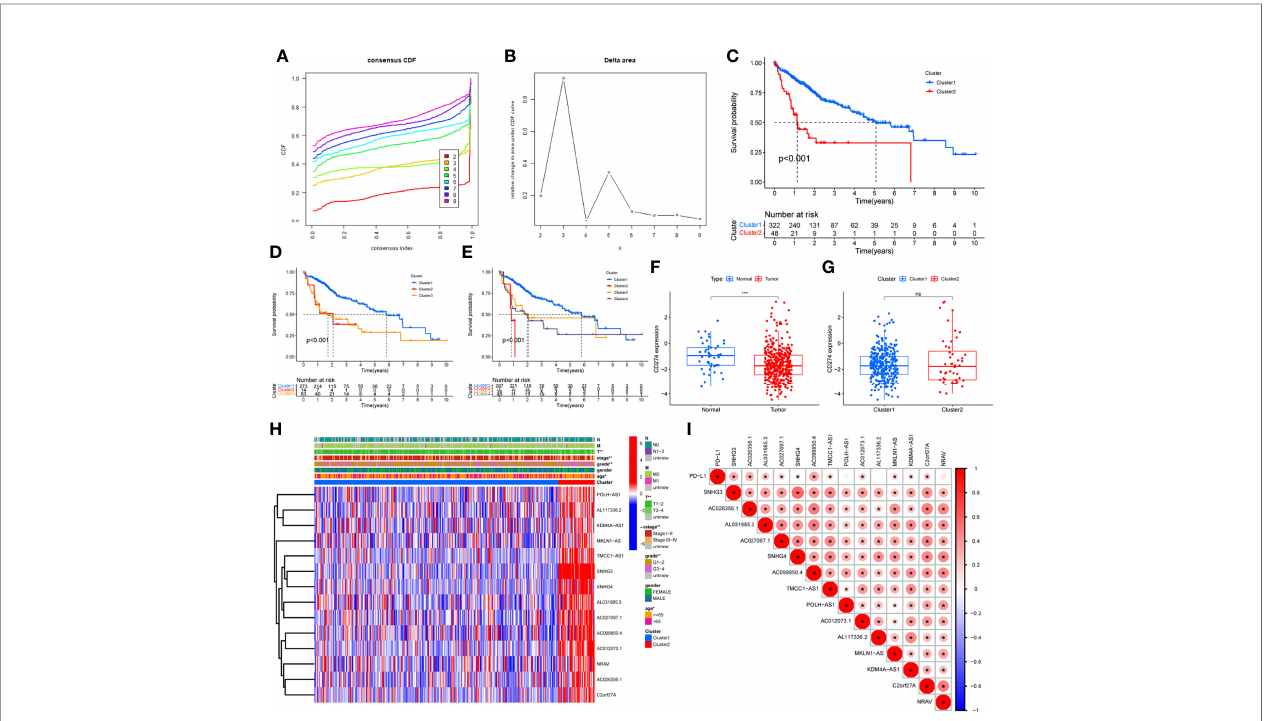
FIGURE 2 | Differential expression, correlation analysis, and survival analysis of lncRNAs. (A, B) Consensus cumulative distribution function and delta area plots, (C – E) Survival analysis by cluster 2 (C) , cluster 3 (D) , cluster 4 (E) , (F, G) Differential analysis of CD274 by tissue type (F) and cluster (G) , (H) LncRNAs and clinical factors- related heatmap, (I) Correlation analysis between lncRNAs and PD-L1. The symbols of “ ns ” means P>0.05. * means P<0.05. ** means P <0.01. *** means